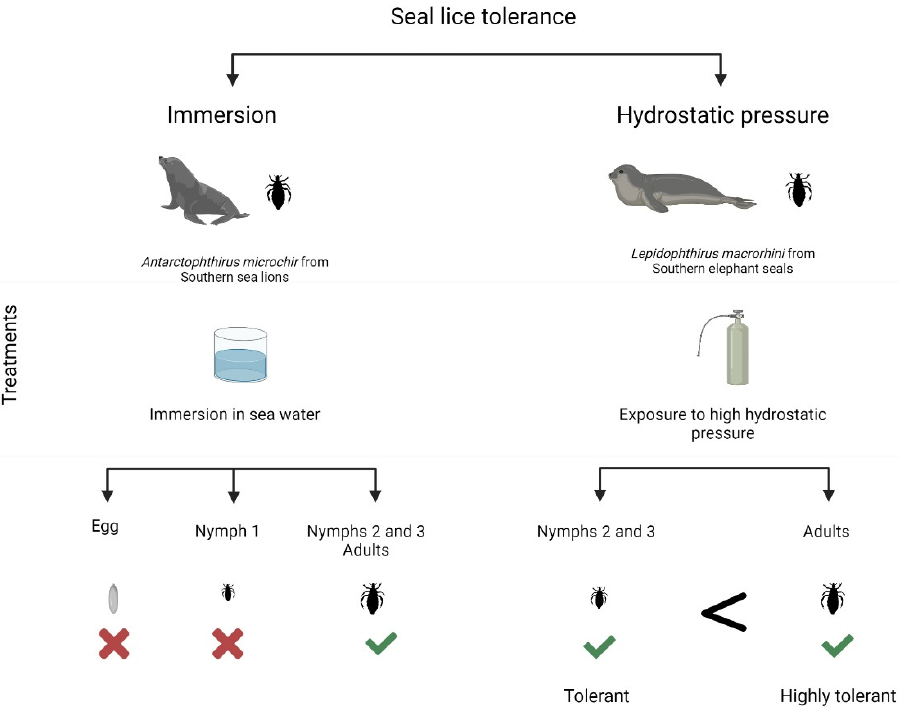
Figure 3. Experimental design and main results testing the tolerance to immersion ( left ) and high hydrostatic pressure ( right ). ✓ indicates survival; ✕ death.